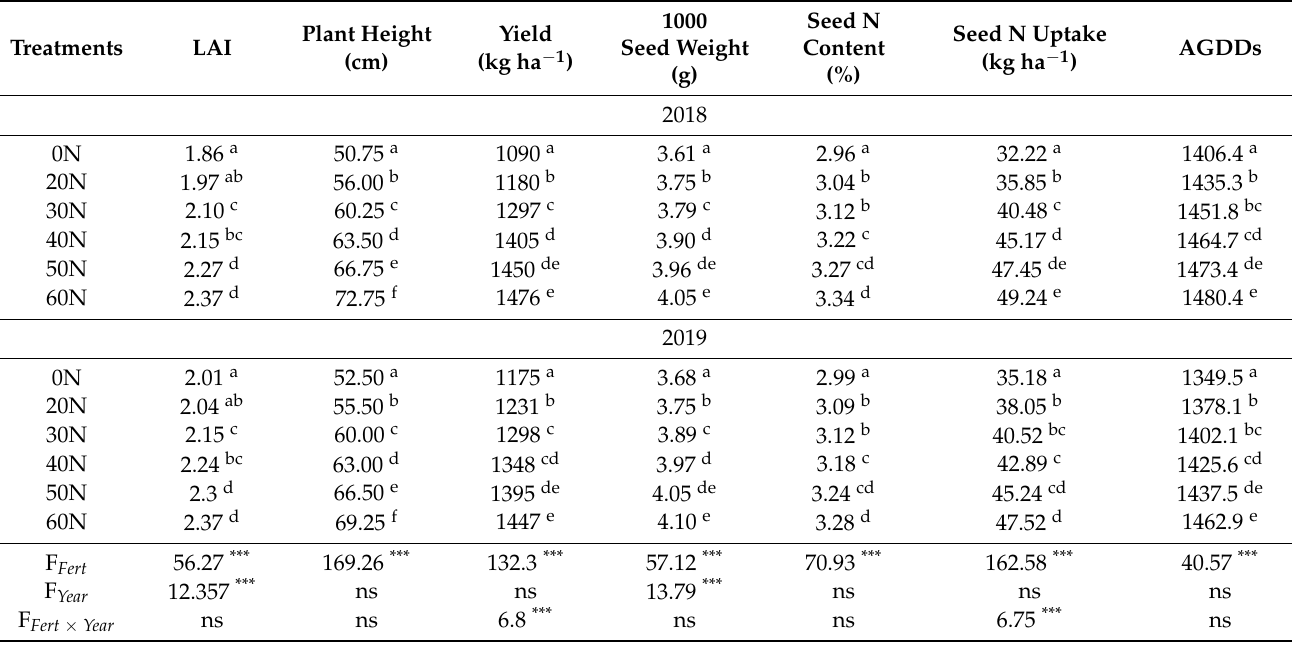
Table 1. The agronomic characteristics of flax, yield, seed N content and uptake, and the AGDDS, as affected by fertilization.